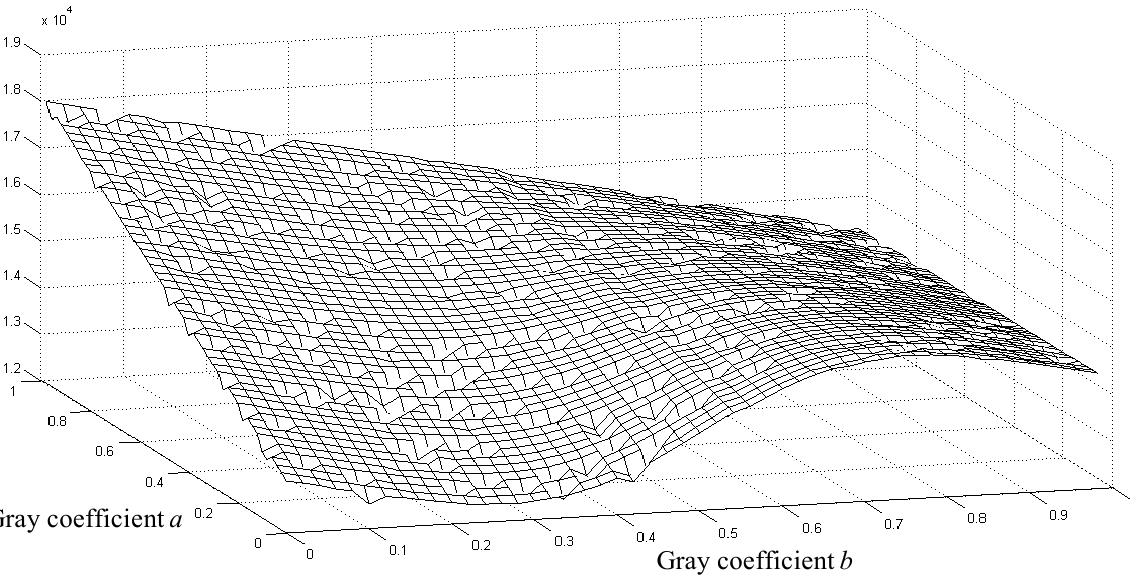
Figure 4. Grey multi-objective programming the global optimal solution surface.